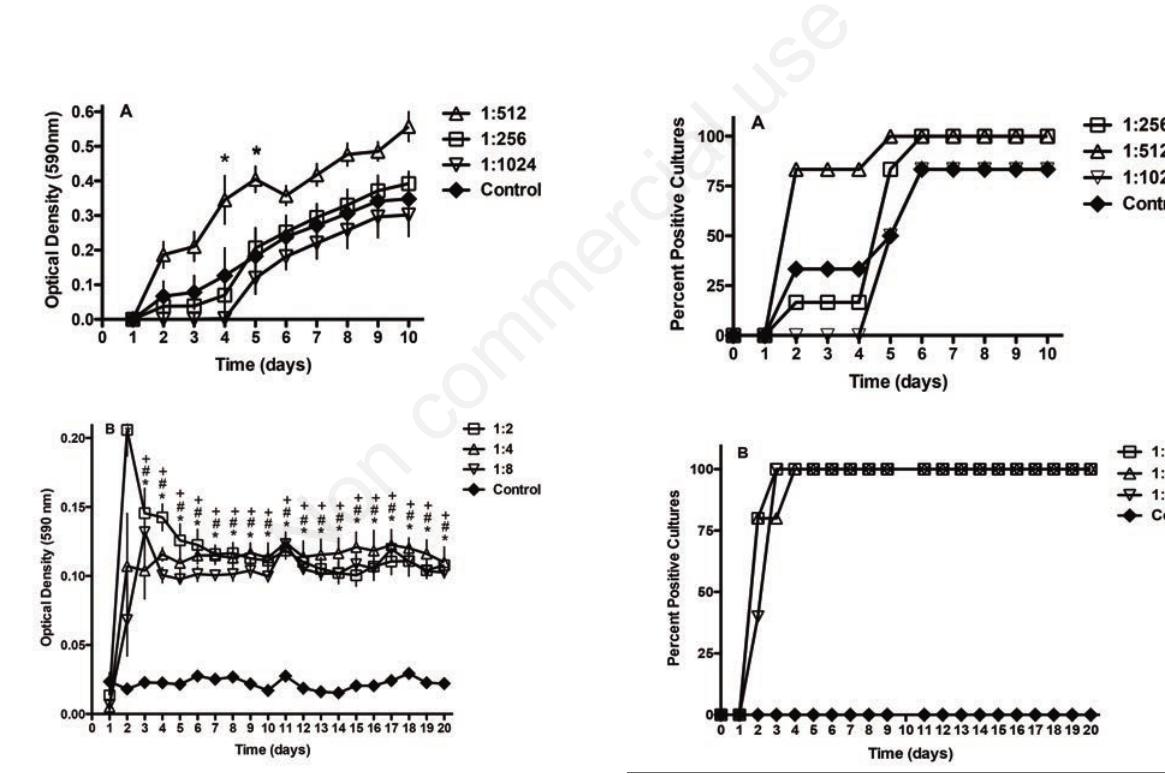
Figure 3. Oxyrase® for Broth (OB) enhances the recovery of Mycobacterium avium subsp. paratuberculosis (MAP). The opti- cal density (590 nm) of MAP grown in Middlebrook 7H9C con- taining serial dilutions of OB was measured until growth ceased or contamination was observed. The average optical density of all inoculated wells on day 0 was subtracted from that of each well at all subsequent time points. Only the dilutions of OB that affected MAP growth are shown. A) Experiment 1. Asterisks indicate sig- nificant differences between controls and 1:512 OB-treated cul- tures (P<0.05). B) Experiment 2. Asterisks, pound signs, and plus- es indicate significant differences between controls and 1:2, 1:4, and 1:8 OB-treated cultures, respectively (P<0.0001).